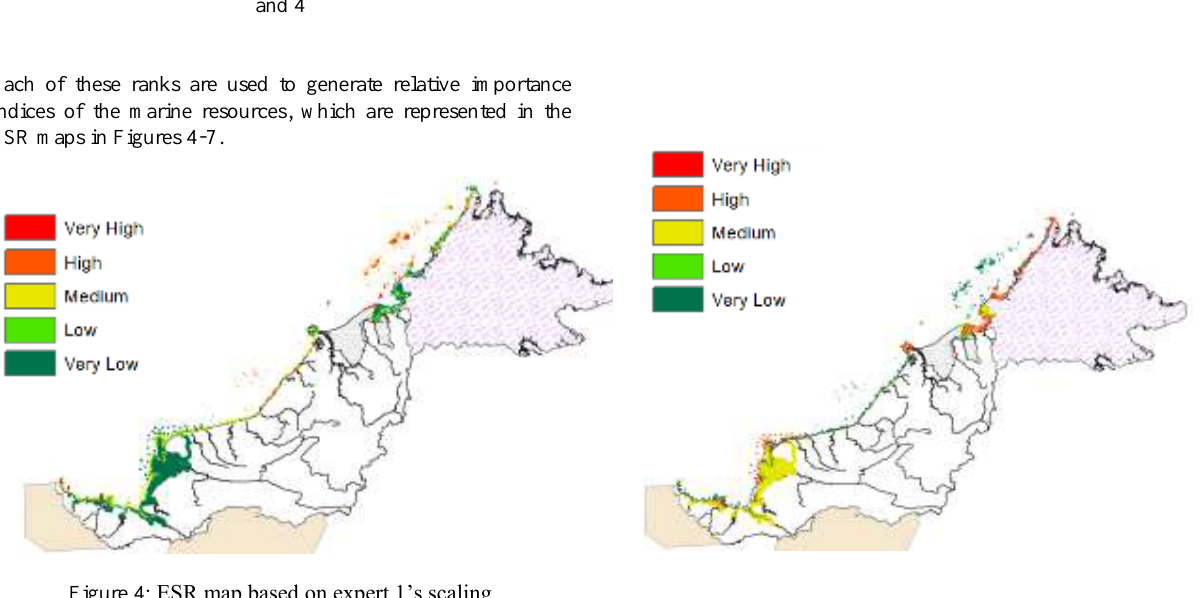
Figure 4: ESR map based on expert 2’s scaling Table 4: Priority ranking of marine resources based on experts 3 and 4’s perspectives Table 4: Prioritization of marine resources at risk by experts 3 and 4